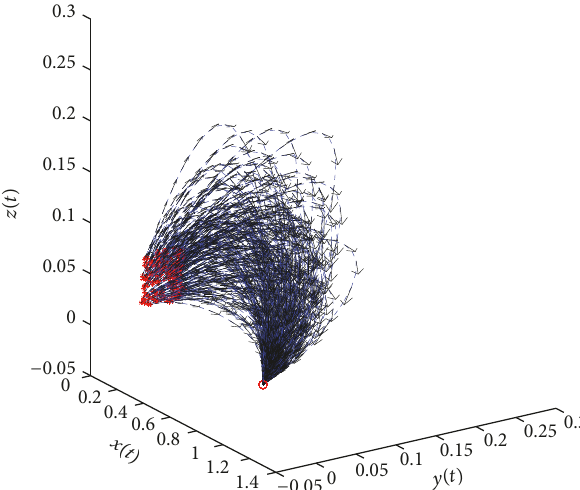
Figure 1: Results where V = 0.1 , 𝑐 = 0.2 . The red cross denotes the equilibrium point 𝑃 1 : (𝑥,𝑦, 𝑧) = (0, 0,1) , and the red circle denotes the equilibrium point 𝑃 4 : (𝑥,𝑦,𝑧) = (0,1,0) .